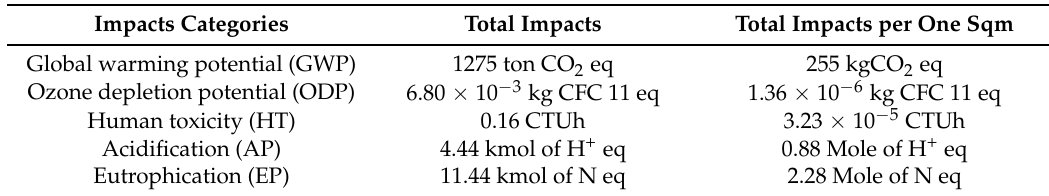
Table 4. The results of total environmental impacts and per one sqm gross floor area impact of the school building by impact